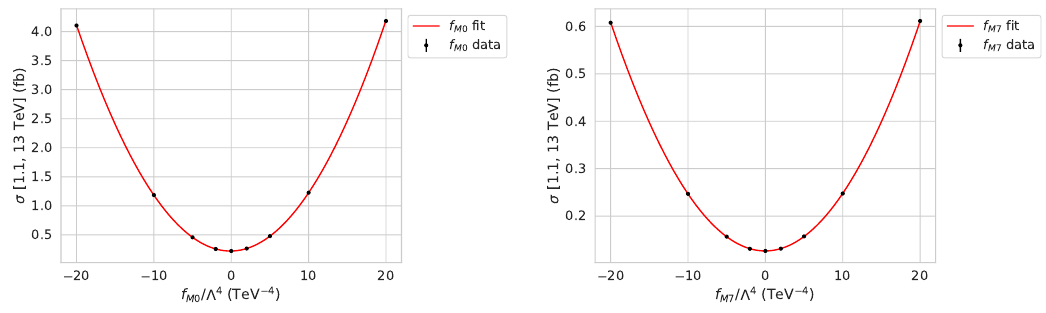
Figure 4 . Examples of quadratic fits of σ [1.1 TeV, 13 TeV] varying the coefficient of a single nonzero dimension-8 operator. Left: f fit for the VBS W ± W ± → 2 ‘ 2 ν process. Right: f M0 VBS W ± Z → 3 ‘ν process. VBS W ± W ± → 2 ‘ 2 ν VBS W ± Z → 3 ‘ν VBS W ± V semileptonic Coeff.